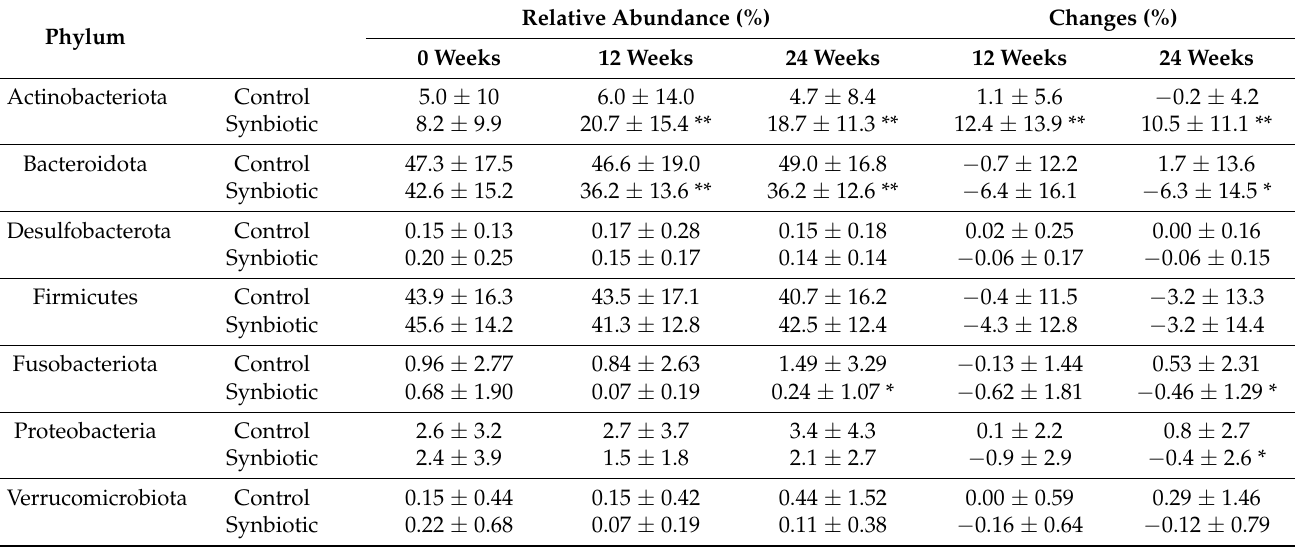
Table 4. Relative abundances of phylum levels and their changes as determined by 16S rRNA sequencing.